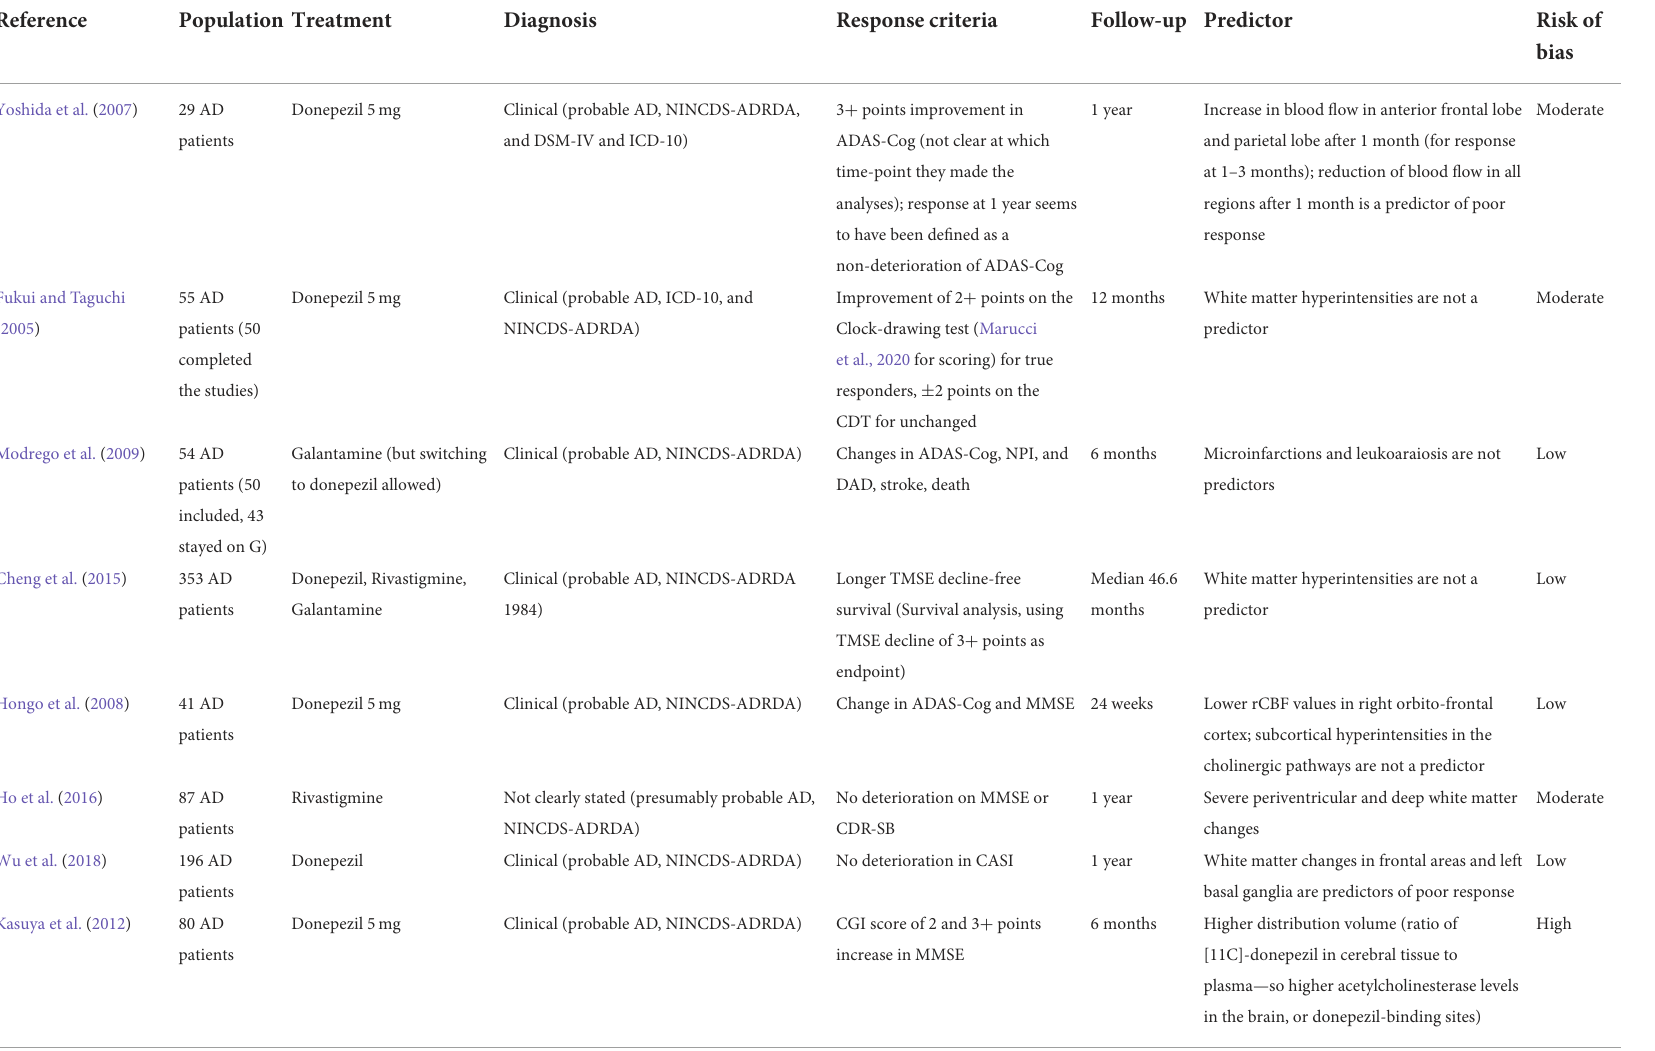
TABLE 3 Indicators of preserved cholinergic